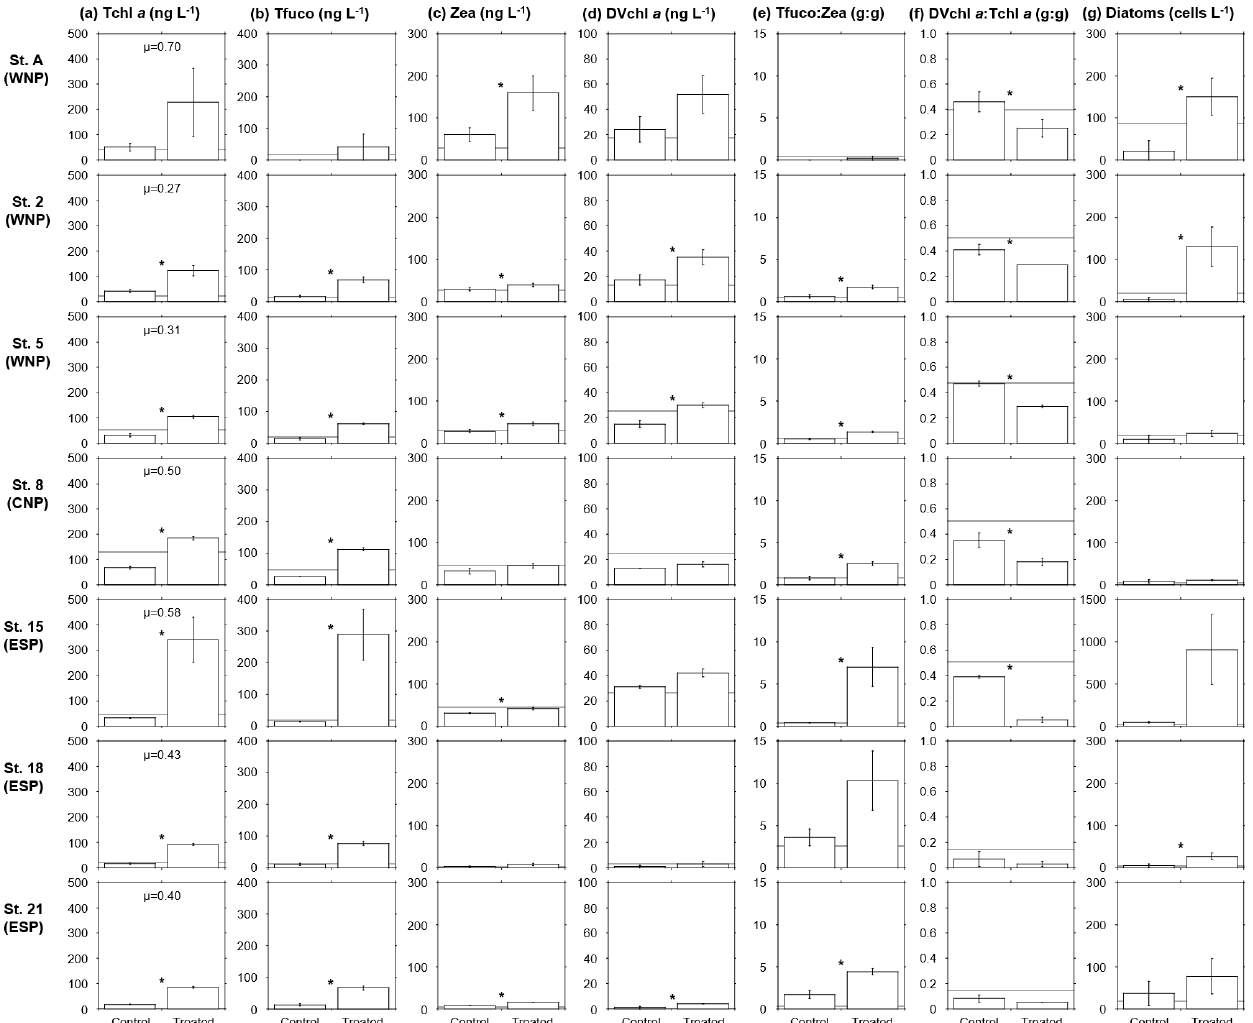
Figure 2. (a) Tchl a , (b) Tfuco, (c) Zea, (d) DVchl a , (e) Tfuco : Zea ratios, (f) DVchl a : Tchl a ratios, and (g) diatom cell densities in the control and treated bottles after 48–96h incubations at seven stations. A grey horizontal line in each panel indicates a mean or single concentration of each pigment at the initial point. Error bars denote standard deviations ( n = 3). Significant differences ( t test, p < 0 . 05) between the values in the control and treated bottles are depicted by asterisks. Net growth rates, µ (d − 1 ), of the phytoplankton blooms (as Tchl a , relative to the control) are denoted in (a) Tchl a . In (g) diatom cell densities, a scale of the y axis at station 15 ( ∼ 1500cellsL − 1 ) is different from those at other stations ( ∼ 300cellsL − 1